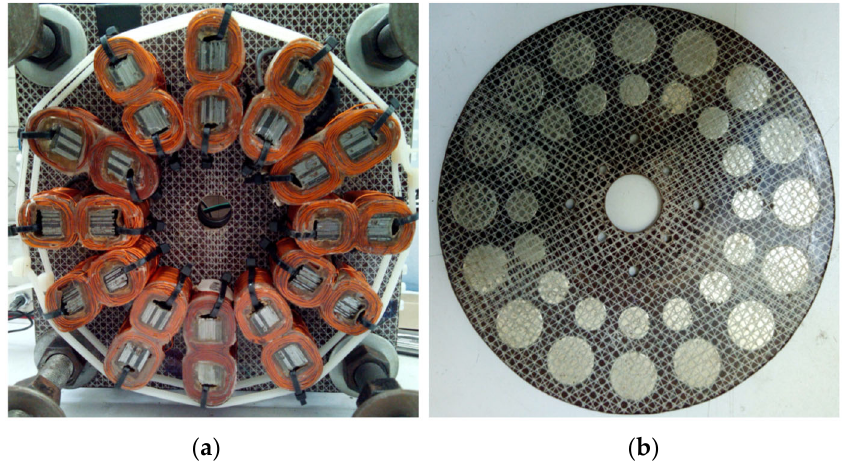
Figure 10. Permanent magnet axial flow motor prototype: ( a ) Motor stator; ( b ) Motor rotor. The general dimensional characteristics of the permanent magnet motor in axial flow configuration are shown in Table 4. Table 4. AFMPM general